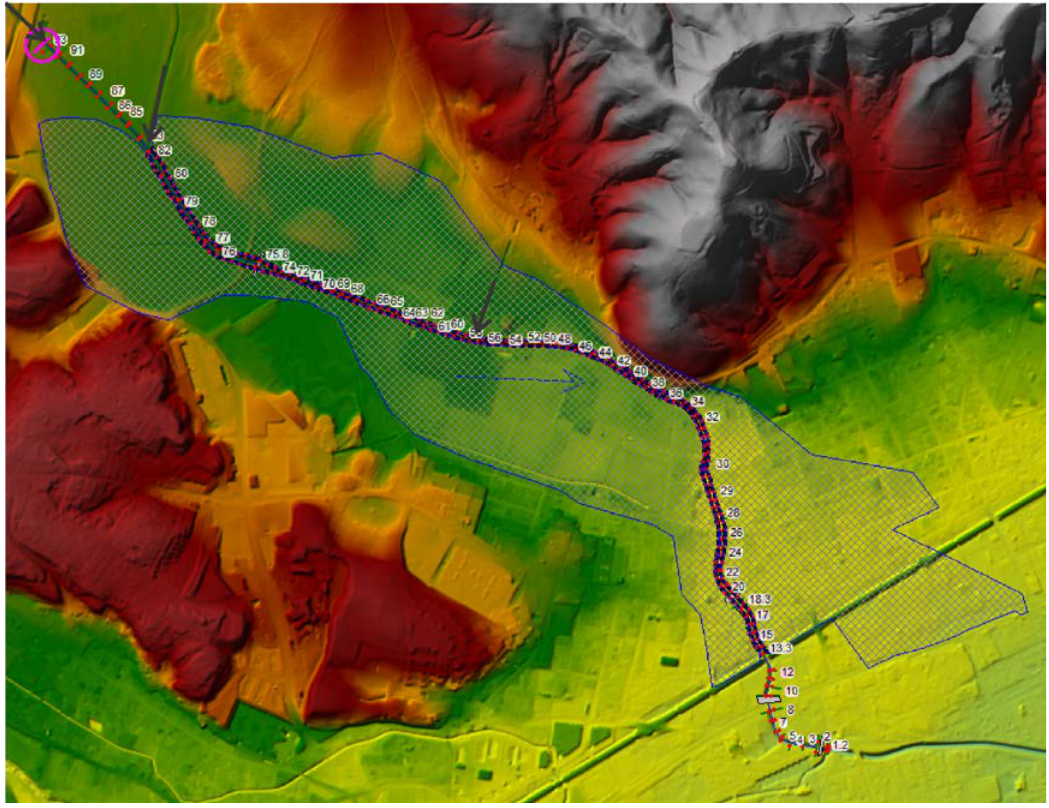
Figure 2. Hydraulic model of the Glinščica Stream catchment with two large 2D flow areas.